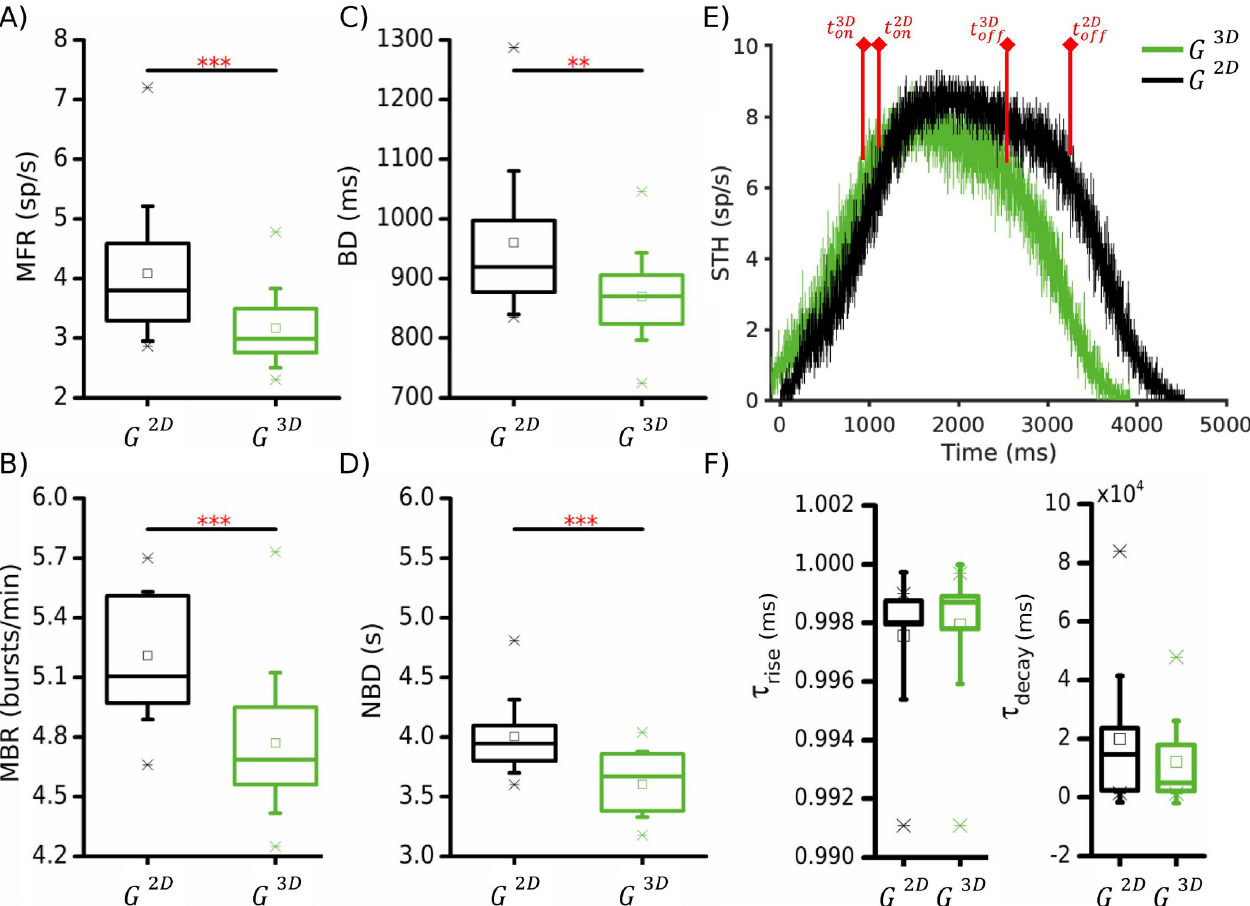
Fig 3. Electrophysiological features of 2D (black, G 2 D ) and readout layer of 3D (green, G 3 D ) networks. ( A ) Mean firing rate, ( B ) mean bursting rate, ( C ) burst duration, ( D ) network burst duration. ( E ) Average Spike Times Histogram (STH) of a 2D and a 3D exemplary configuration (bin = 1 ms). t on and t off indicate the temporal instant when the plateau phase of the network burst starts and ends, respectively. ( F ) Temporal time constants of the ( left ) rise and ( right ) decay phases of the network bursts. In these statistics, we have considered all the simulated structural 3D networks. ( � refers to 0.01 < p < 0.05, �� 0.001 < p < 0.01, ��� p < 0.001, Kruskal-Wallis non-parametric